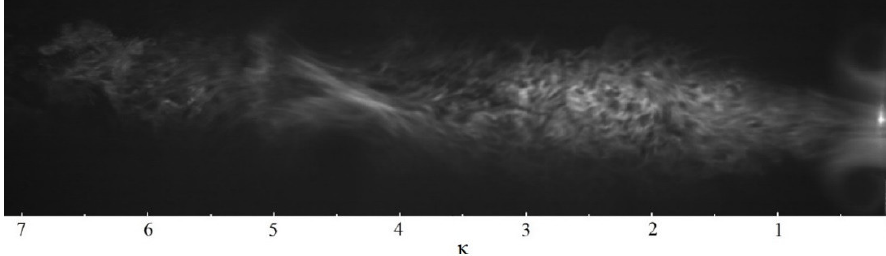
Figure 8. Longitudinal section of the acoustic flow.